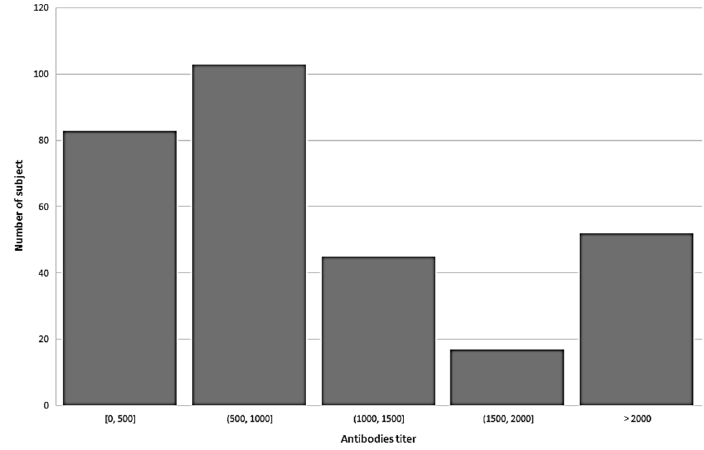
Figure 1. Distribution of antibody titre among study population. Table 1. Study population characteristics by vaccination and serological status .